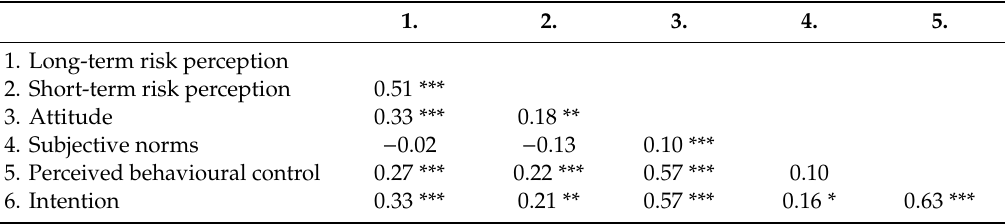
Table 1. Bivariate Correlations of Study